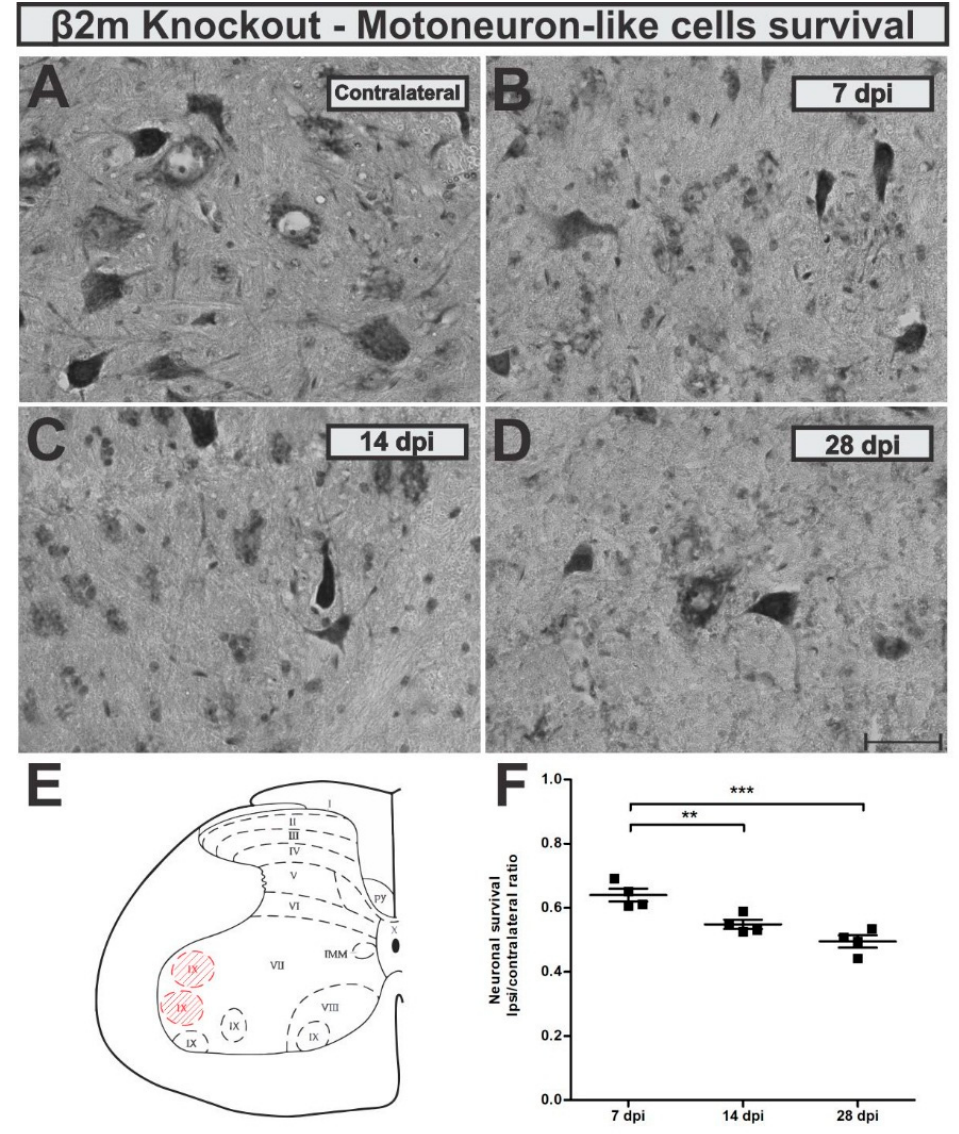
Figure 6. Time-course of motoneuron-like cell survival in the β 2m knockout mice ( A ) contralateral - unlesioned, ( B ) 7 dpi, ( C ) 14 dpi and ( D ) 28 dpi. ( E ) Schematic spinal cord transverse section showing